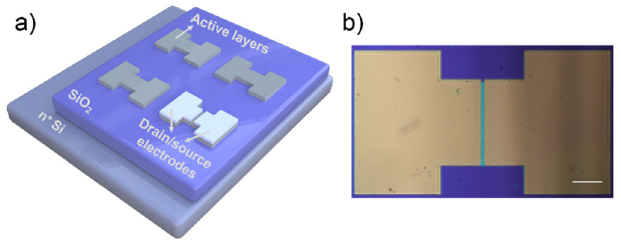
Figure 1. ( a ) Schematic diagram of fabrication of a metal oxide TFT device. ( b ) Microscope image of the channel pattern. The scale bar is 100 μ m.